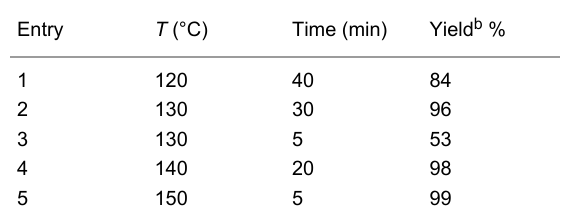
Table 2: Temperature and time variations for the synthesis of 5-aminopyrazole 2a . a Entry T (°C) Time (min) Yield b % 1 120 40 84 2 130 30 96 3 130 5 53 4 140 20 98 5 150 5